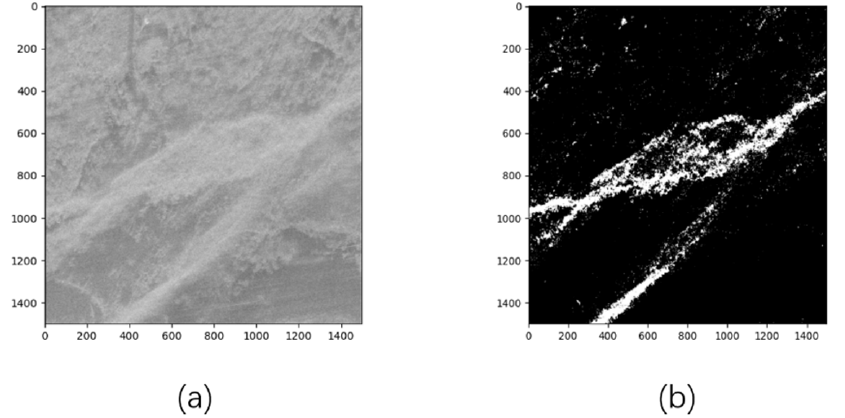
Figure 11. The layover detection result of our method in the actual data: ( a ) shows the selected SAR image; ( b ) shows the layover detection result of our method.